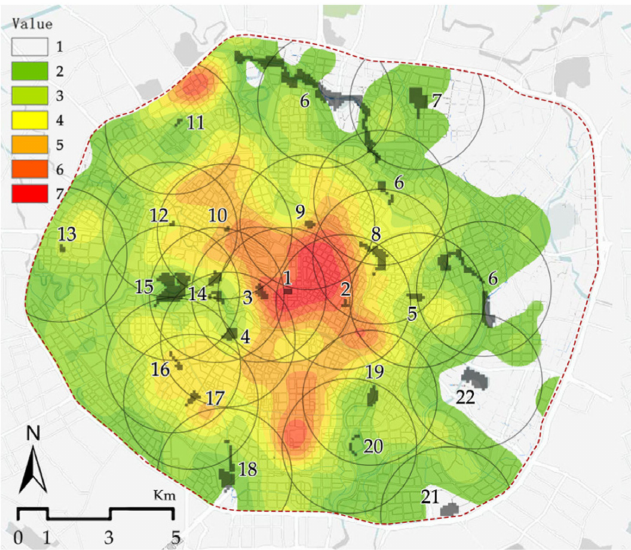
Figure 5. Spatial heterogeneity of functional